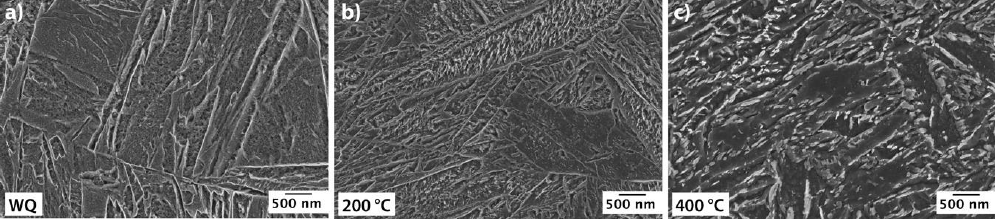
Figure 4. FESEM images of ( a ) water quenched, ( b ) tempered at 200 °C for 2 hours and ( c ) tempered at 400 °C for 2 hours.